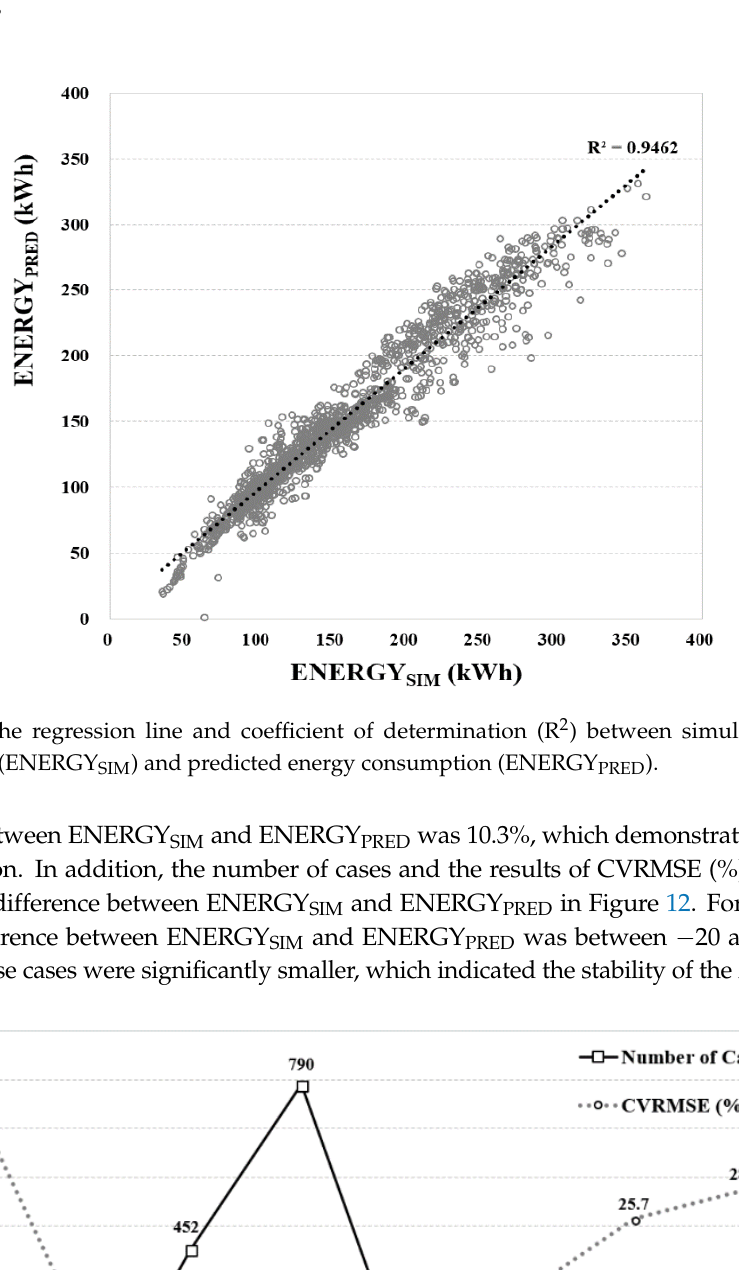
Figure 12. Number of cases and CVRMSE (%) for difference between simulated energy consumption and predicted energy consumption.